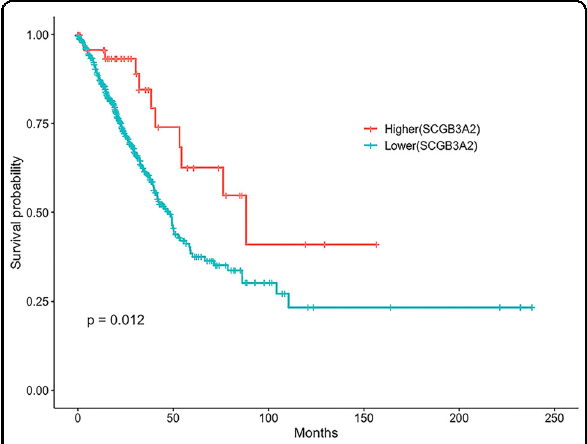
Fig. 5 TCGA data analysis. Survival curve for lung adenocarcinoma patients ( n = 494) expressing higher SCGB3A2 (red, n = 49, top 10%) or lower SCGB3A2 (blue, n = 445, remaining